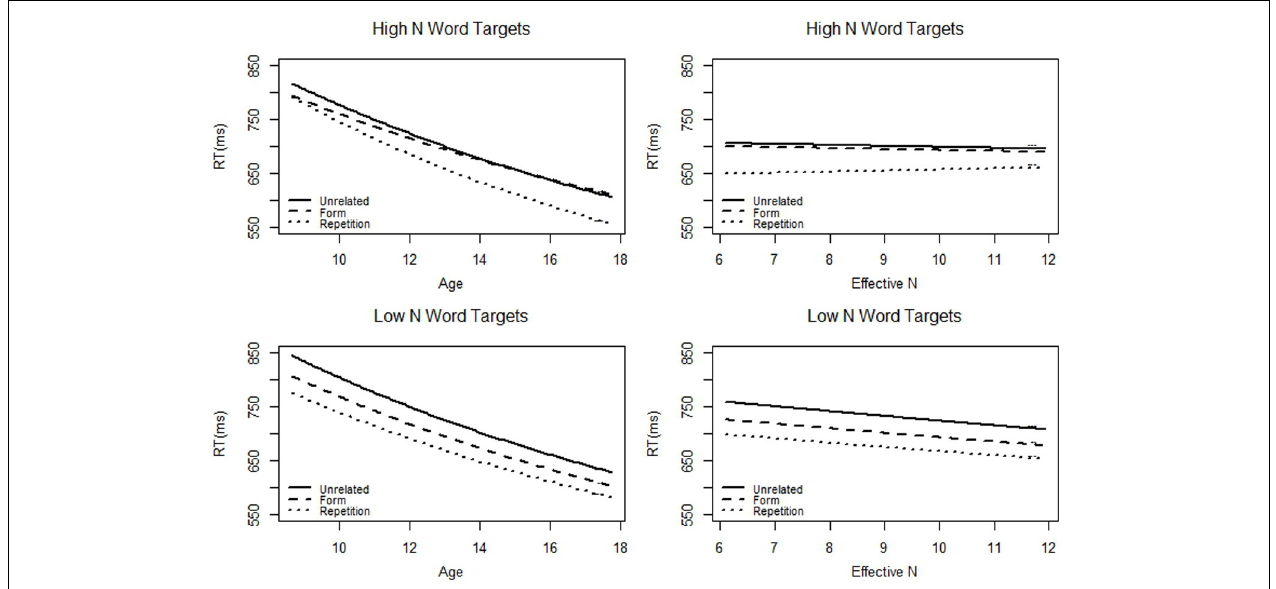
FIGURE 3 | The predicted (based on our models) average reaction time to targets preceded by the three different prime types as a function of age (in years) or effective N (in number of neighbors known) for just children and adolescents. Effective N was calculated using the neighbor knowledge test.